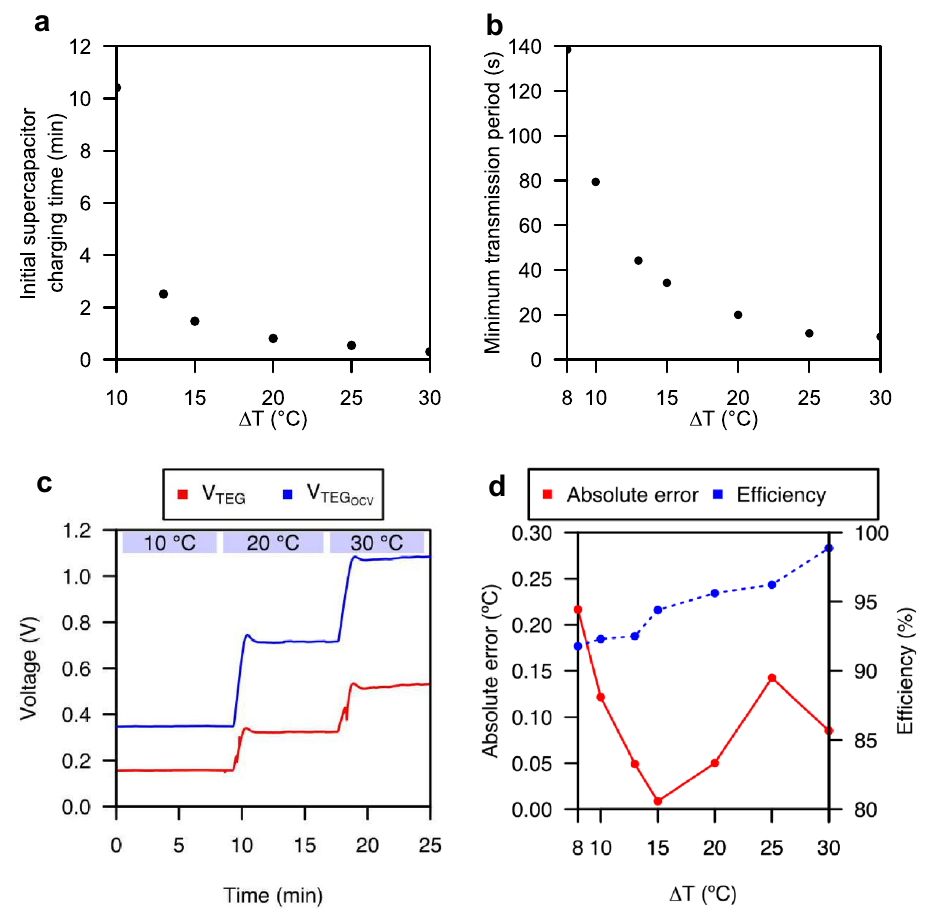
Figure 5. Characterization results of the device. ( a ) Time required by the device to charge the initially discharged supercapacitor to 5V to enable wireless communication. ( b ) Time period between transmissions versus temperature gradient. ( c ) Thermoelectric generator’s operating ( V TEG ) and open-circuit ( V TEG OCV ) voltages for different temperature gradients ( (cid:31) T ). ( d ) Absolute error of the temperature gradient measurement and efficiency power extraction η TEG